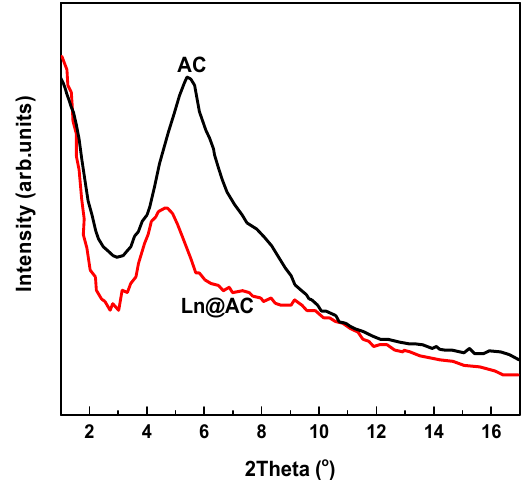
Figure1. XRDpatternsoftheAC(activatedclay)andLn@AC(lignocellulose@activatedclay)nanocomposite. Figure 1. XRD patterns of the AC (activated clay) and Ln@AC (lignocellulose@activated clay) nanocomposite.